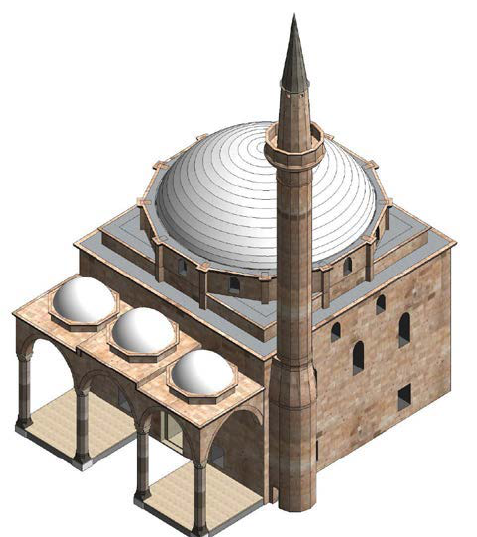
Figure 8. 3d model in Autodesk